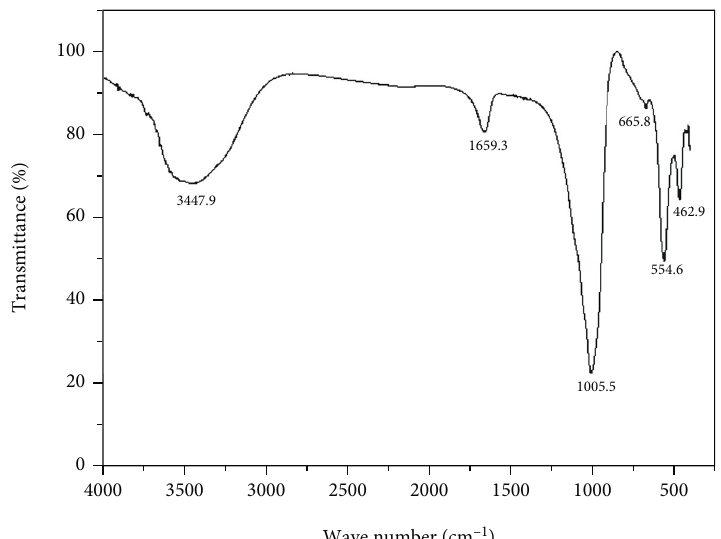
Figure 3: IR spectra of zeolite 3A.